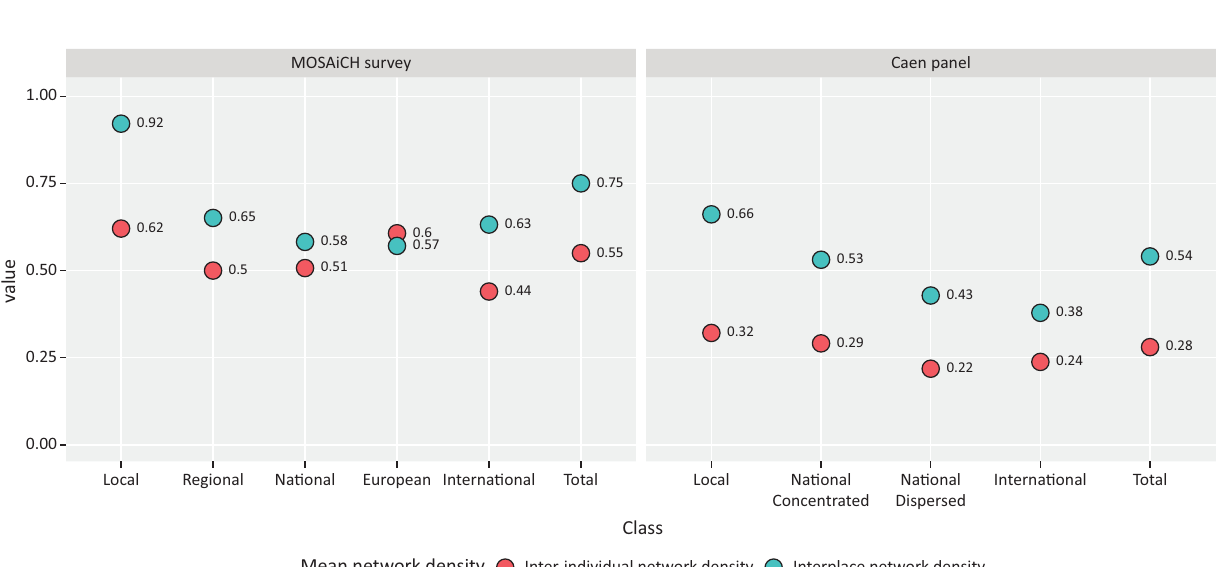
Figure 7. Classes by ego’s residential mobility.